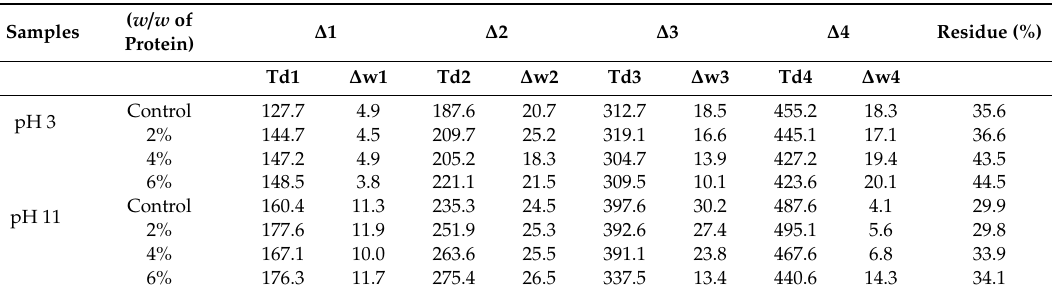
Figure 2. ( A , B ). Thermo-gravimetric curves of weight loss for silver carp surimi-based edible films at pH 3 and pH 11 incorporated with different concentrations of green tea extract (GTE). ( A ) GTE (pH 3) (2%, 4% and 6%); ( B ) 2%, 4%, 6% GTE pH 11, Control (without added GTE at both pH). Table 5. Thermal degradation temperature (Td, °C) and weight loss (Δw, %) of films incorporated with GTE at different concentrations of green tea extract (GTE) at pH 3 and pH 11. Δ 1 , Δ 2 , Δ 3 , and Δ 4 represent first, second, third, and fourth stages, respectively, of weight loss of films during the heating scan .